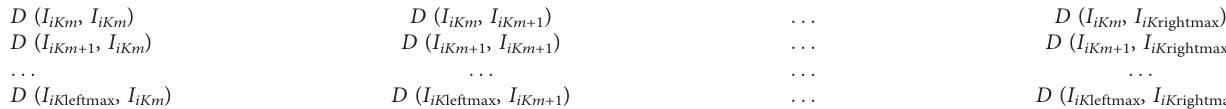
Table 1: Euclidean distance table.